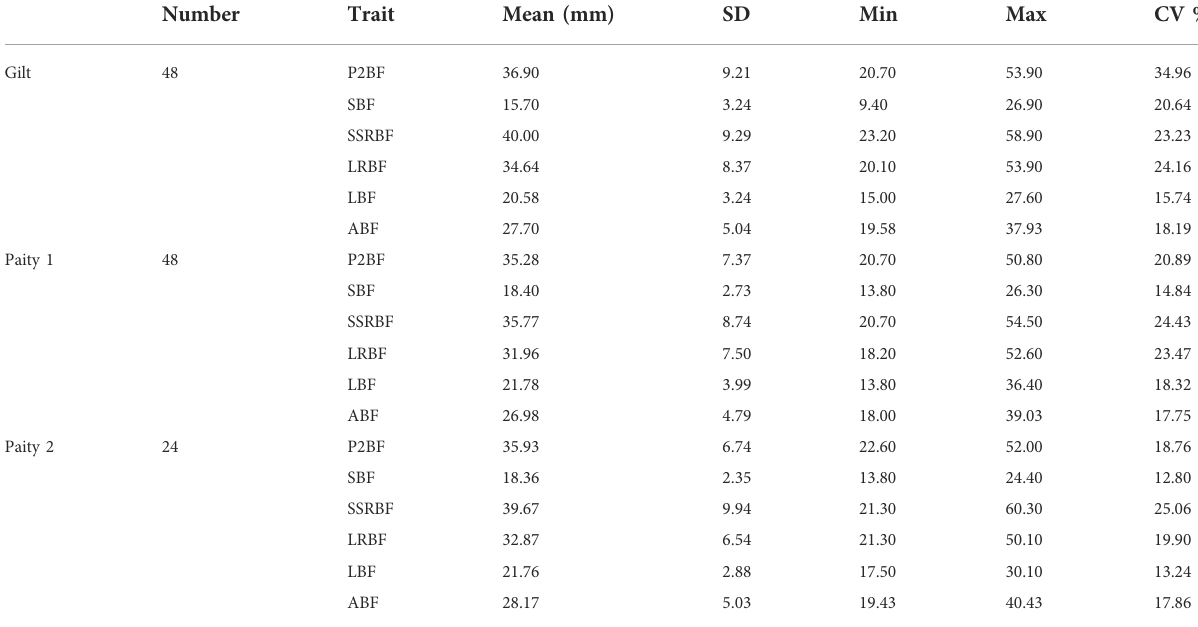
TABLE 4 Descriptive statistical of backfat traits in Yunan